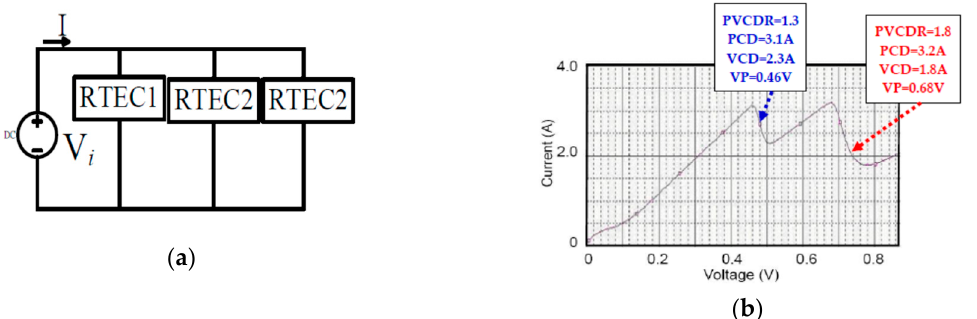
Figure 6. ( a ) Improvement of double PVCDR RTEC structure by paralleled the third RTEC unit. ( b ) Improvement of NDR characteristic with different and asymmetry PVCDR values after paralleled another same single PVCDR RTEC unit.